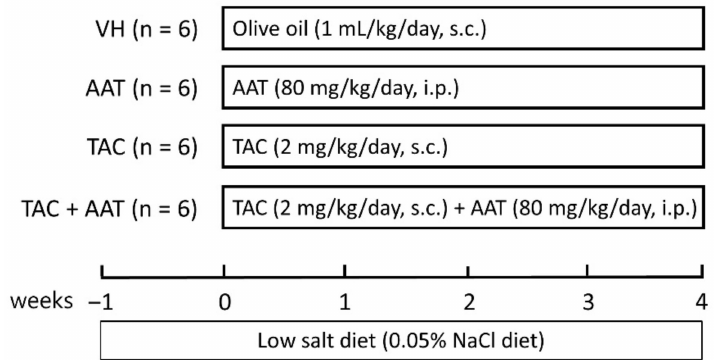
Figure 8. Schematic diagram of the study design. Abbreviations: VH, vehicle group; AAT, alpha-1 antitrypsin treatment group; TAC, tacrolimus treatment group; TAC + AAT, tacrolimus and alpha-1 antitrypsin cotreatment group; s.c., subcutaneous injection; i.p., intraperitoneal